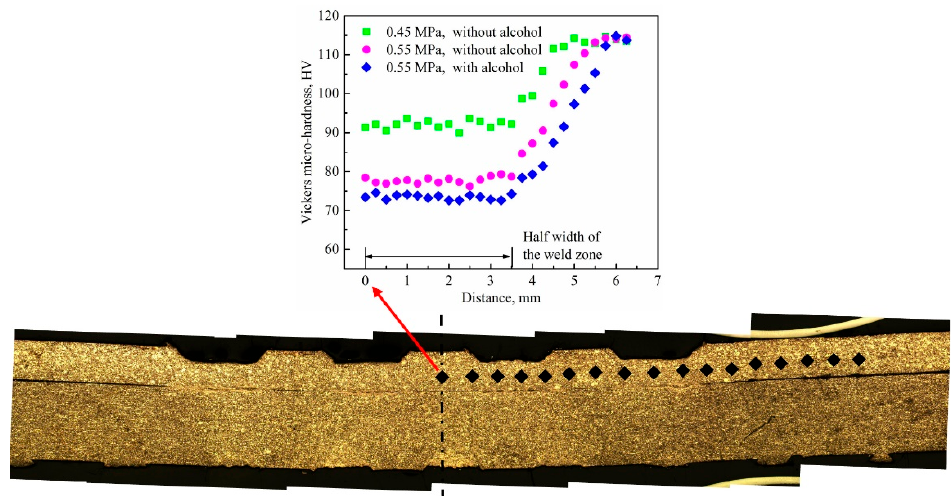
Figure 9. Vickers micro-hardness along the half thickness of the top sheet cross-section of the joints.